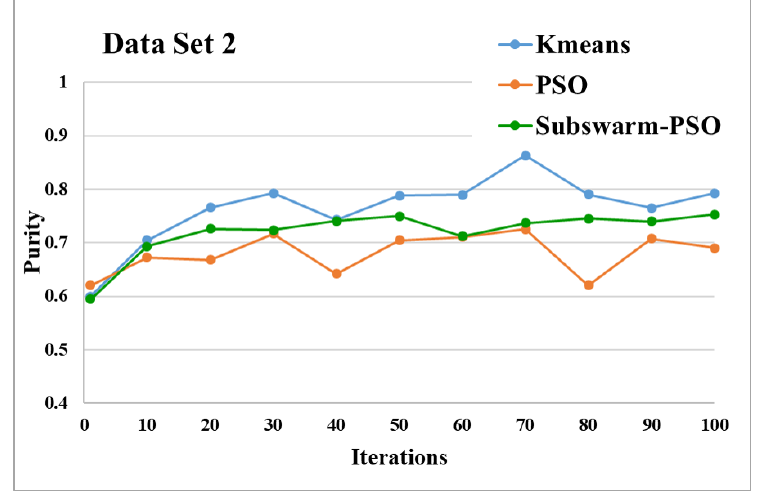
Figure 7. Purity comparison for data set 2.